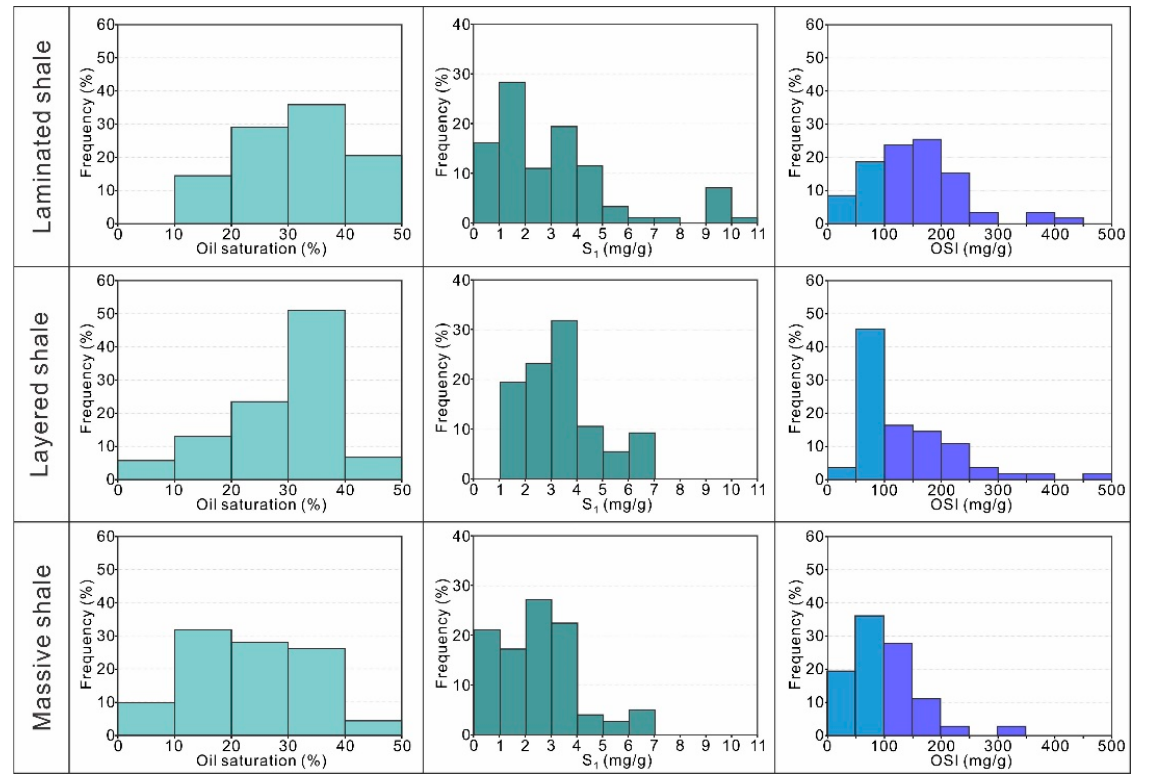
Figure 7. Distribution characteristics of oil saturation, S 1 , and oil saturation index (OSI) for different types of shale. Date from [28,75,76,87,111,124].